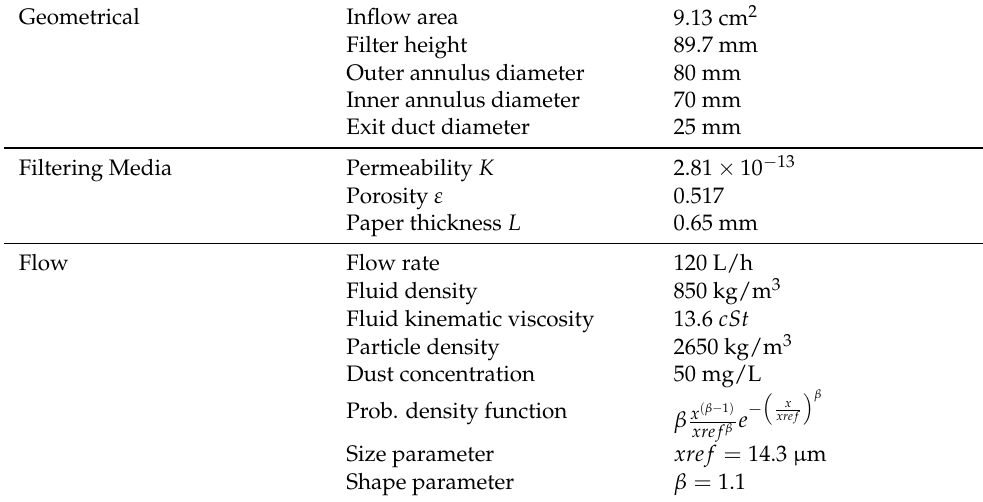
Table 1. Flow properties and geometrical data. The intake area is the area of the annulus of the filter, taking out the small section of the internal separating walls. Filtering paper K11B40A. Fluid